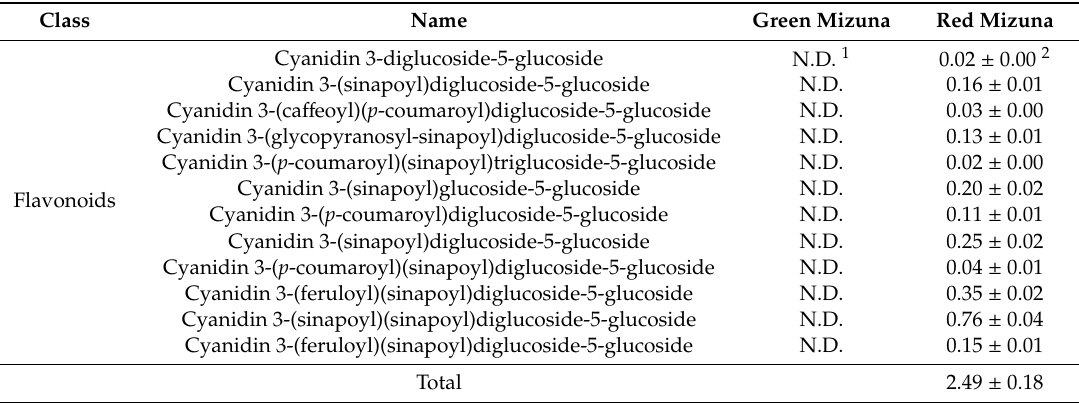
Table 4. Anthocyanin content in green and red kale. ( µ mol / g dry